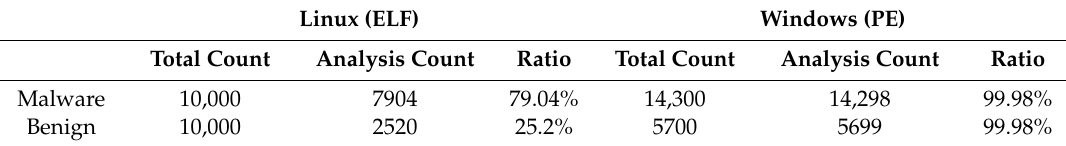
Table 3. Number of parsed data based on ELF and PE file formats in Linux and